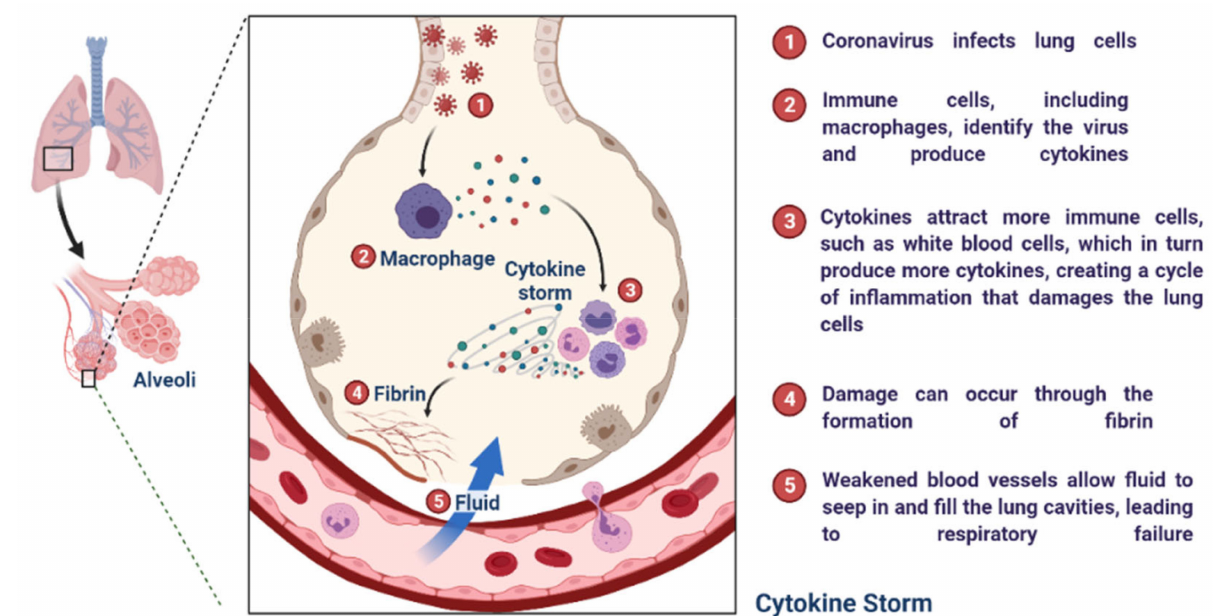
Figure 6. Cytokine storm: When cytokines are triggered without breaks, they can cause damage to the cells responding to the cytokines and shut down the function of the organs. This is known as a cytokine storm, which mediates severe disease, including COVID-19.